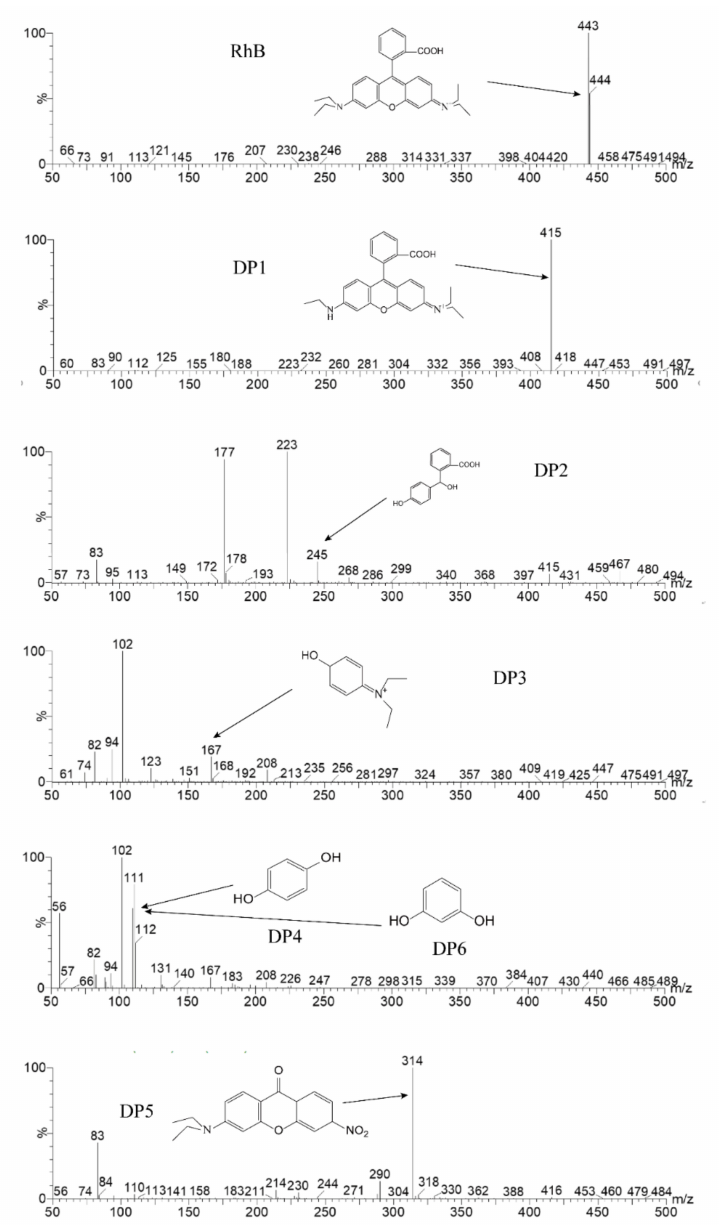
Figure 9. The identification results of the intermediates of